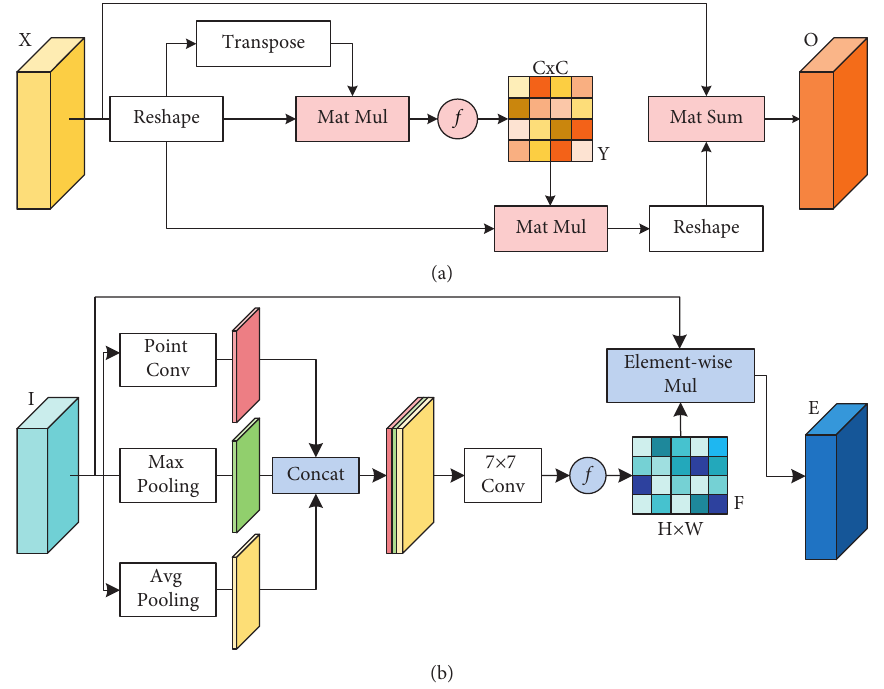
Figure 5: Schematic diagram of CAM (a) and SAM